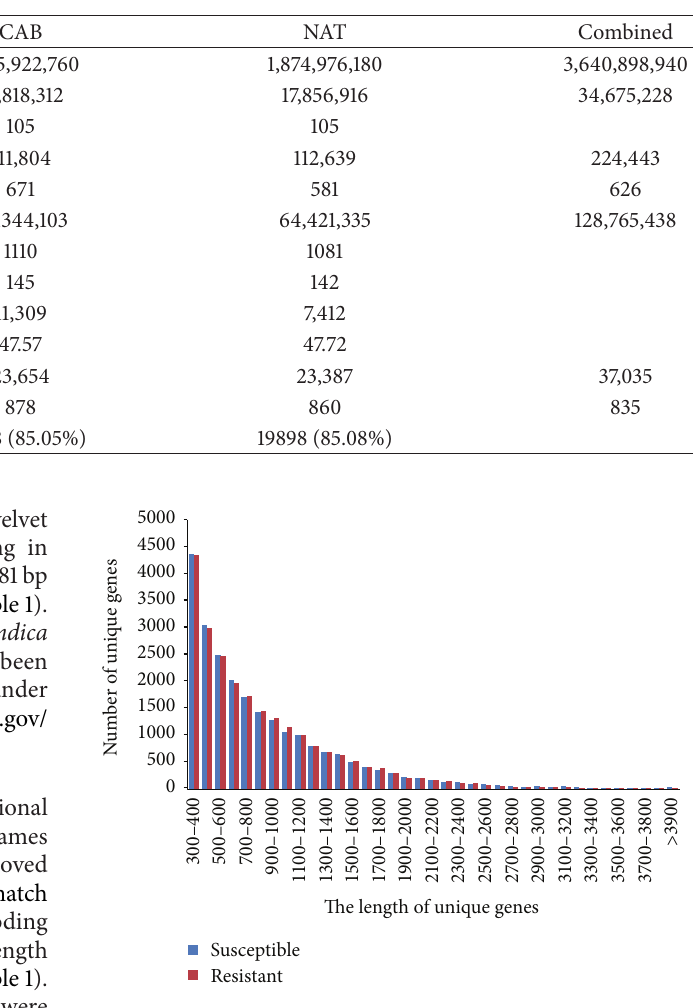
Figure 1: Length distribution of unigenes in the assembled tran- scriptomes of two Lagerstroemia indica cultivars: powdery mildew susceptible (Carolina Beauty, CAB) and powdery mildew resistant (Natchez,